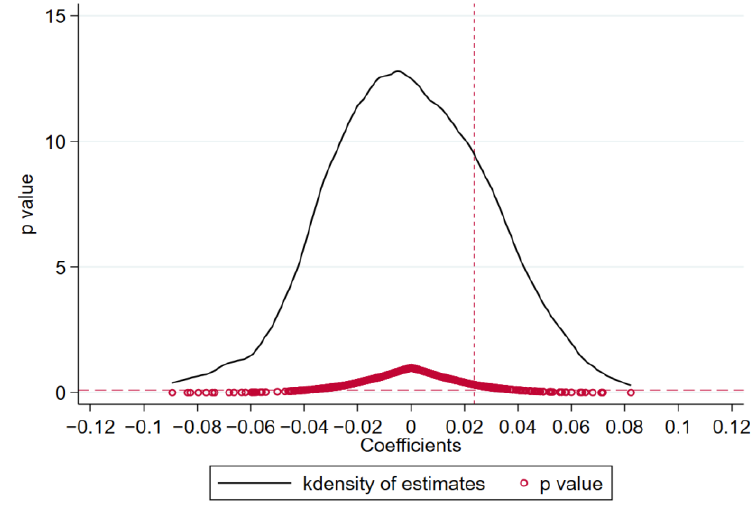
Figure 8. Placebo Test.